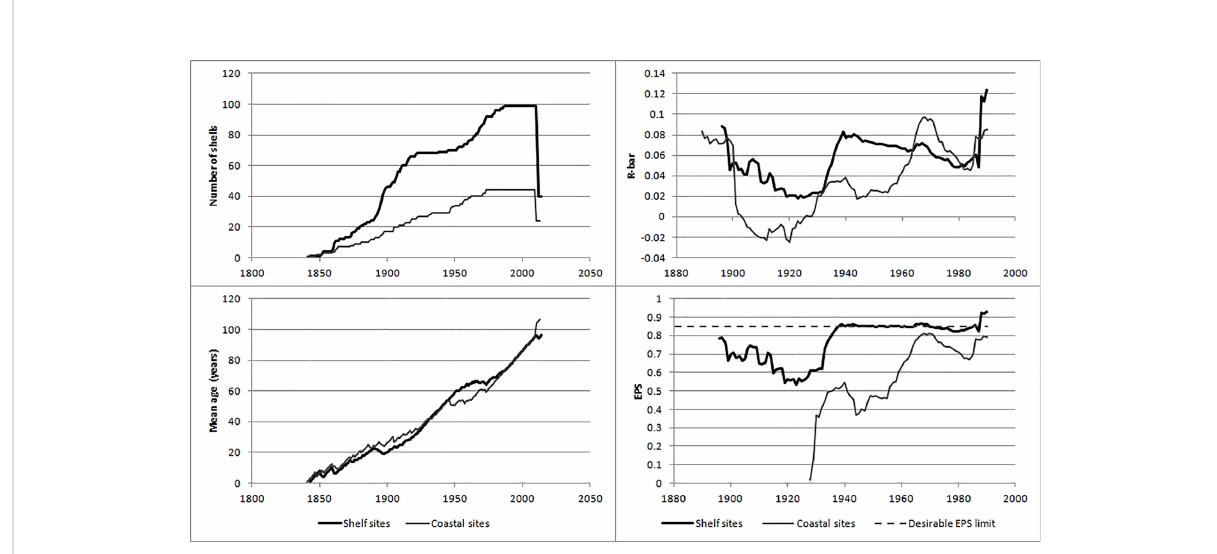
FIGURE 4 Statistics associated with the shelf and coastal A. islandica growth indices. Upper left: the number of shells as basis for the indices, lower left: the corresponding mean age for the shells, upper right: the average correlation coef fi cients for moving 50-year windows, lower right: the corresponding Expressed Population Signal, EPS. The true age is 15 years older than the ‘ mean age ’